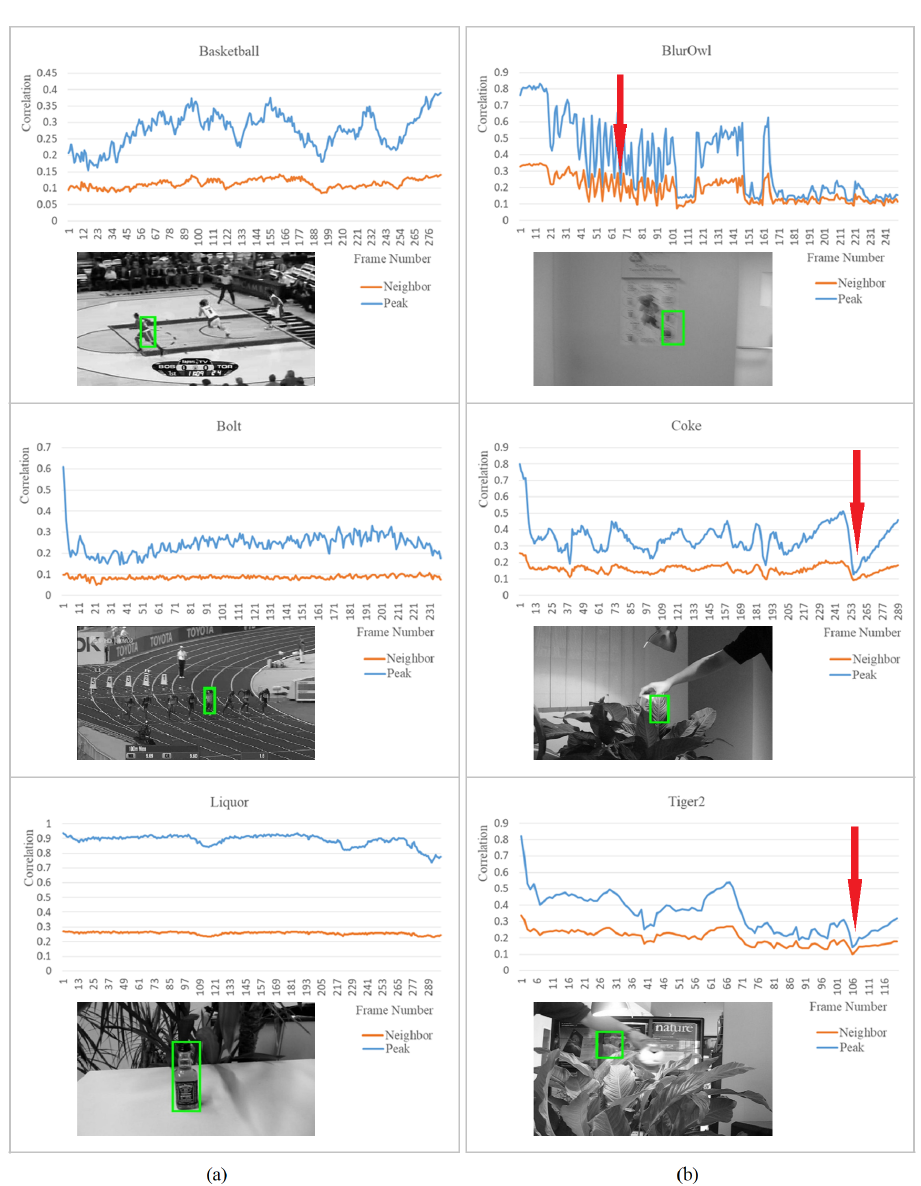
Figure 3. Comparison of peak values and average values of neighbor area around the peak. ( a ) Correlation developments with successfully tracked targets. ( b ) Correlation developments in sequences including tracking